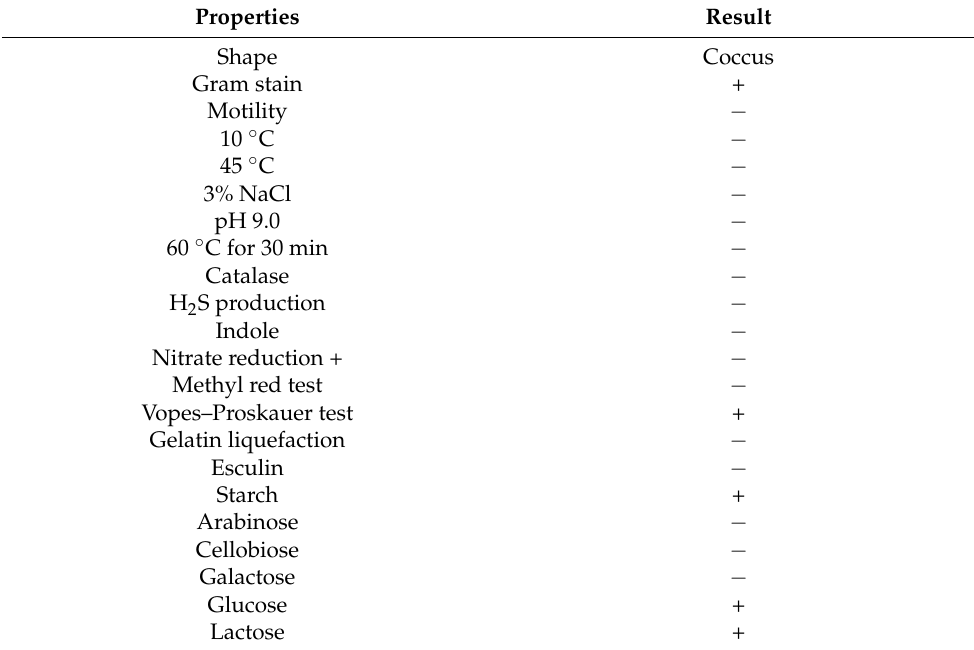
Table 1. Morphological, physiological, and biochemical characteristics of the strain